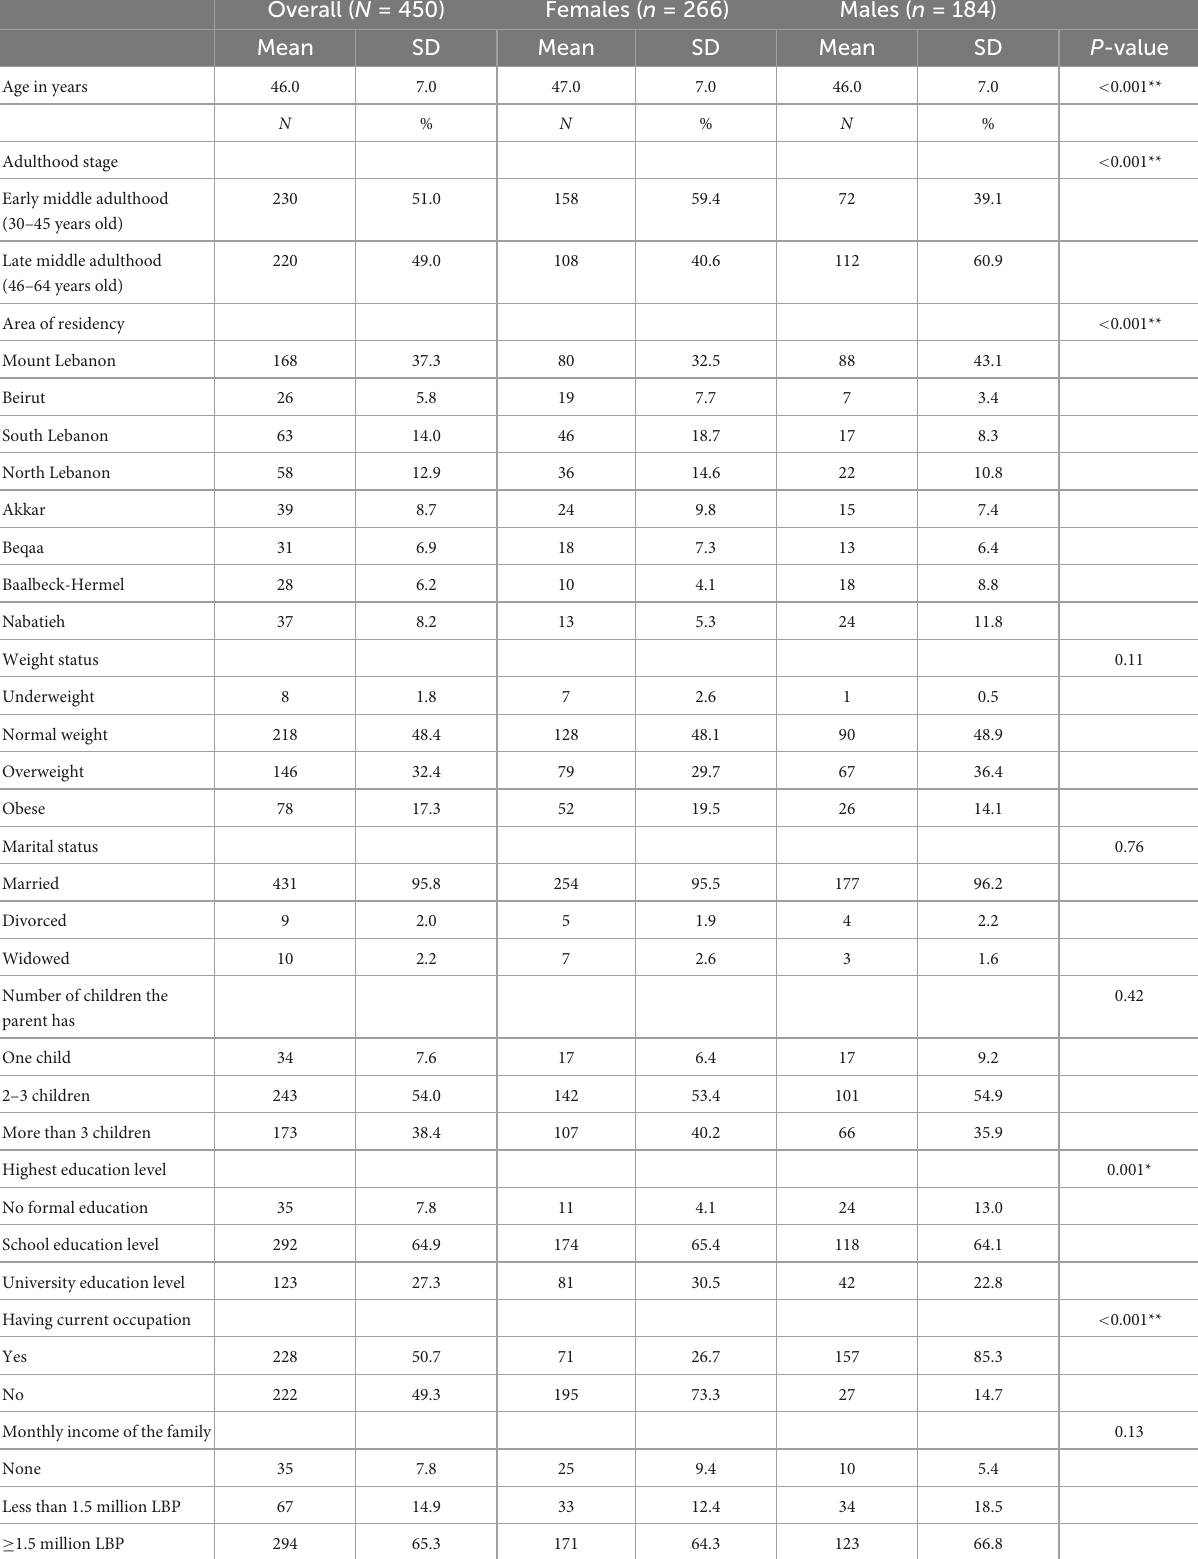
TABLE 1 Demographic and socioeconomic characteristics of parent participants and the household food security